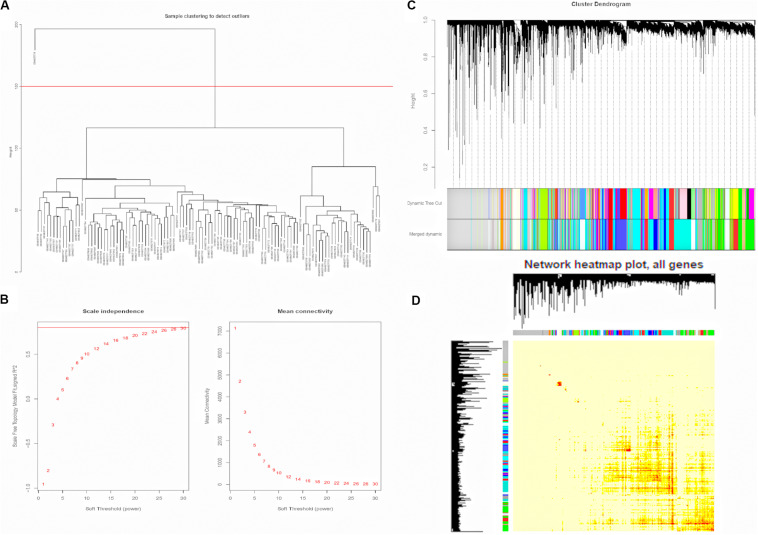
Construction of Weighted Gene Co-expression Network. (A) GSM827775 was excluded from the samples. (B) Analysis of the scale-free topology model fit index for soft threshold powers (β) and the mean connectivity for soft threshold powers. (C) The cluster dendrogram of genes in GSE33463. Each branch means one gene. Each color means one co-expressed module. (D) Interactive relationship analysis of co-expression genes. The light color indicates topological overlap, while the darker color indicates a high topological overlap. PAH, pulmonary arterial hypertension; ILD, interstitial lung disease.